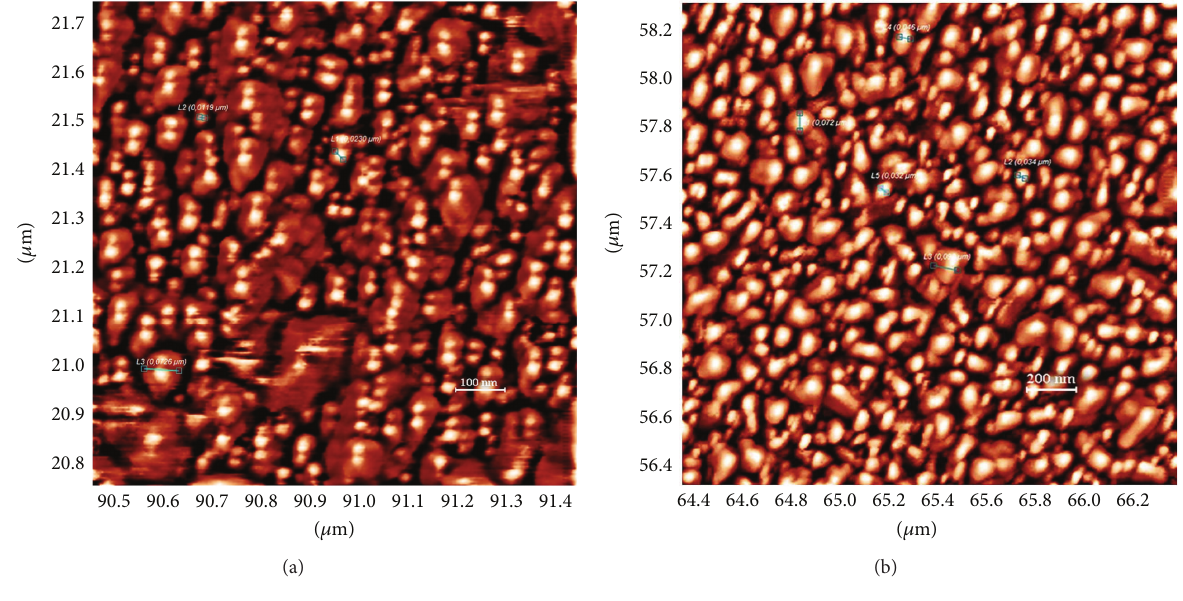
Figure 3: AFM micrographs of thin film surface for (a) Zn 0.97 Ni 0.03 O and (b) Zn 0.90 Ni 0.10 O.